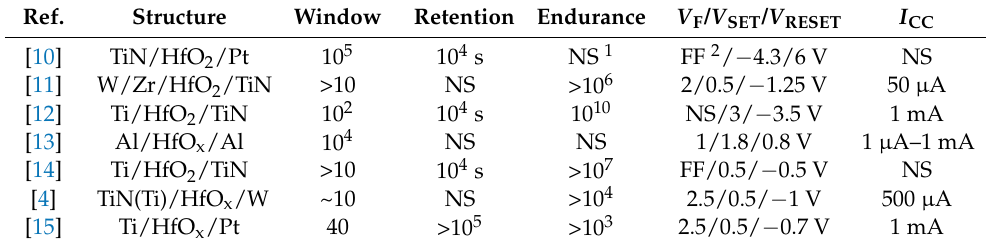
Table 1. Benchmark of bipolar HfO x -based RRAM.